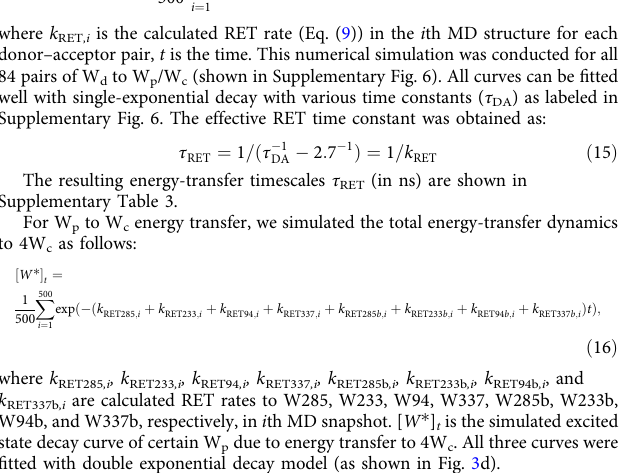
To consider conformational distribution of UVR8, the RET rates in 500 snapshots from a 2- μ s simulation trajectory were calculated. For every snapshot, the transition dipole moment was calculated for each tryptophan chromophore using described QM/MM methods above. Energy-transfer rates were calculated using Eq. (9). For each donor – acceptor pair, 500 RET rates were obtained from 500 MD structures. RET rate distributions were plotted in Fig. 3a – c and Supplementary Fig. 5.